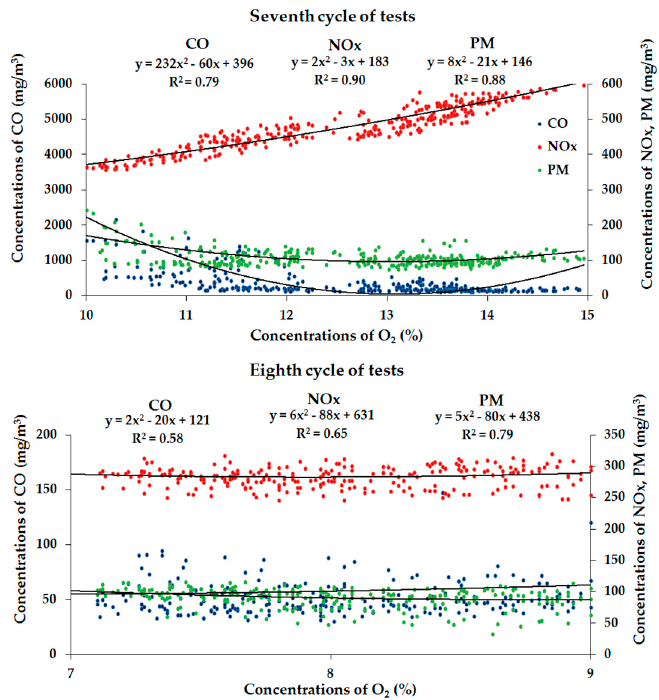
Figure 9. Mass distribution of harmful substances to the remaining amount of oxygen for the seventh and eighth cycles of tests.